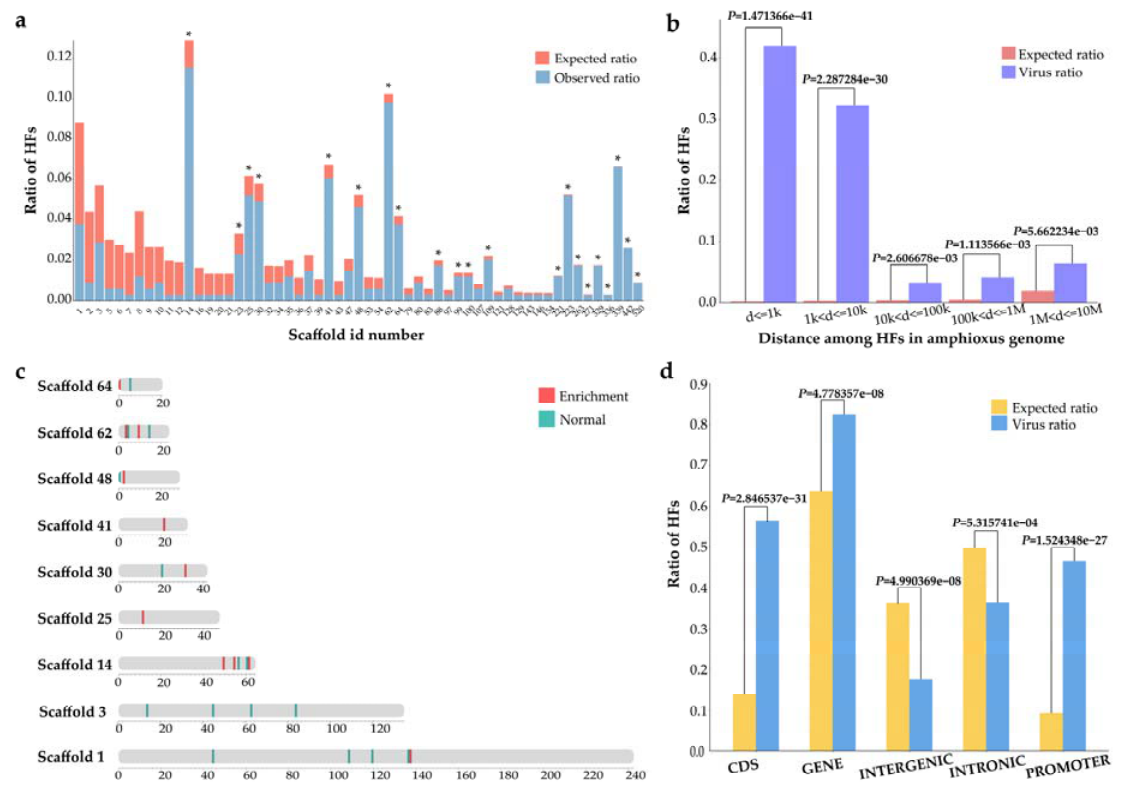
Figure 3. The distribution of HFs in the B. belcheri beihai genome. ( a ) The distribution of HFs on scaffold level. Black star represents statistically significant difference (adjusted p value < 0.05) between the observed number of HFs and expected (random) number of HFs in each scaffold. Adjusted p value were calculated by X 2 test (using the Bonferroni method). ( b ) The distance between neighbor HFs in the B. belcheri beihai genome. The number of HFs within multiple distances was calculated. A uniformly random distribution of HFs across the entire B. belcheri beihai genome was used to calculate the expected ratio. Pink bar shows the expected ratio of HFs. Purple bar shows the observed ration of HFs. These p values were calculated by X 2 test. ( c ) Distribution of HFs in each 100 kb sliding windows on scaffolds. Scaffolds with no less than 10 HFs and length greater than 1000 kb were shown in figure. Sliding windows enriched with HFs were colored as red ( p < 0.01, X 2 test); sliding windows without enrichment of HFs were colored as green. ( d ) The distribution of HFs in functional genomic regions of the B. belcheri beihai genome. The expected (random distribution, yellow) and the observed (actual numbers, blue) ratios of fragments in the CDS, gene, intergenic, intron and promoter are shown. These p values were calculated by X 2